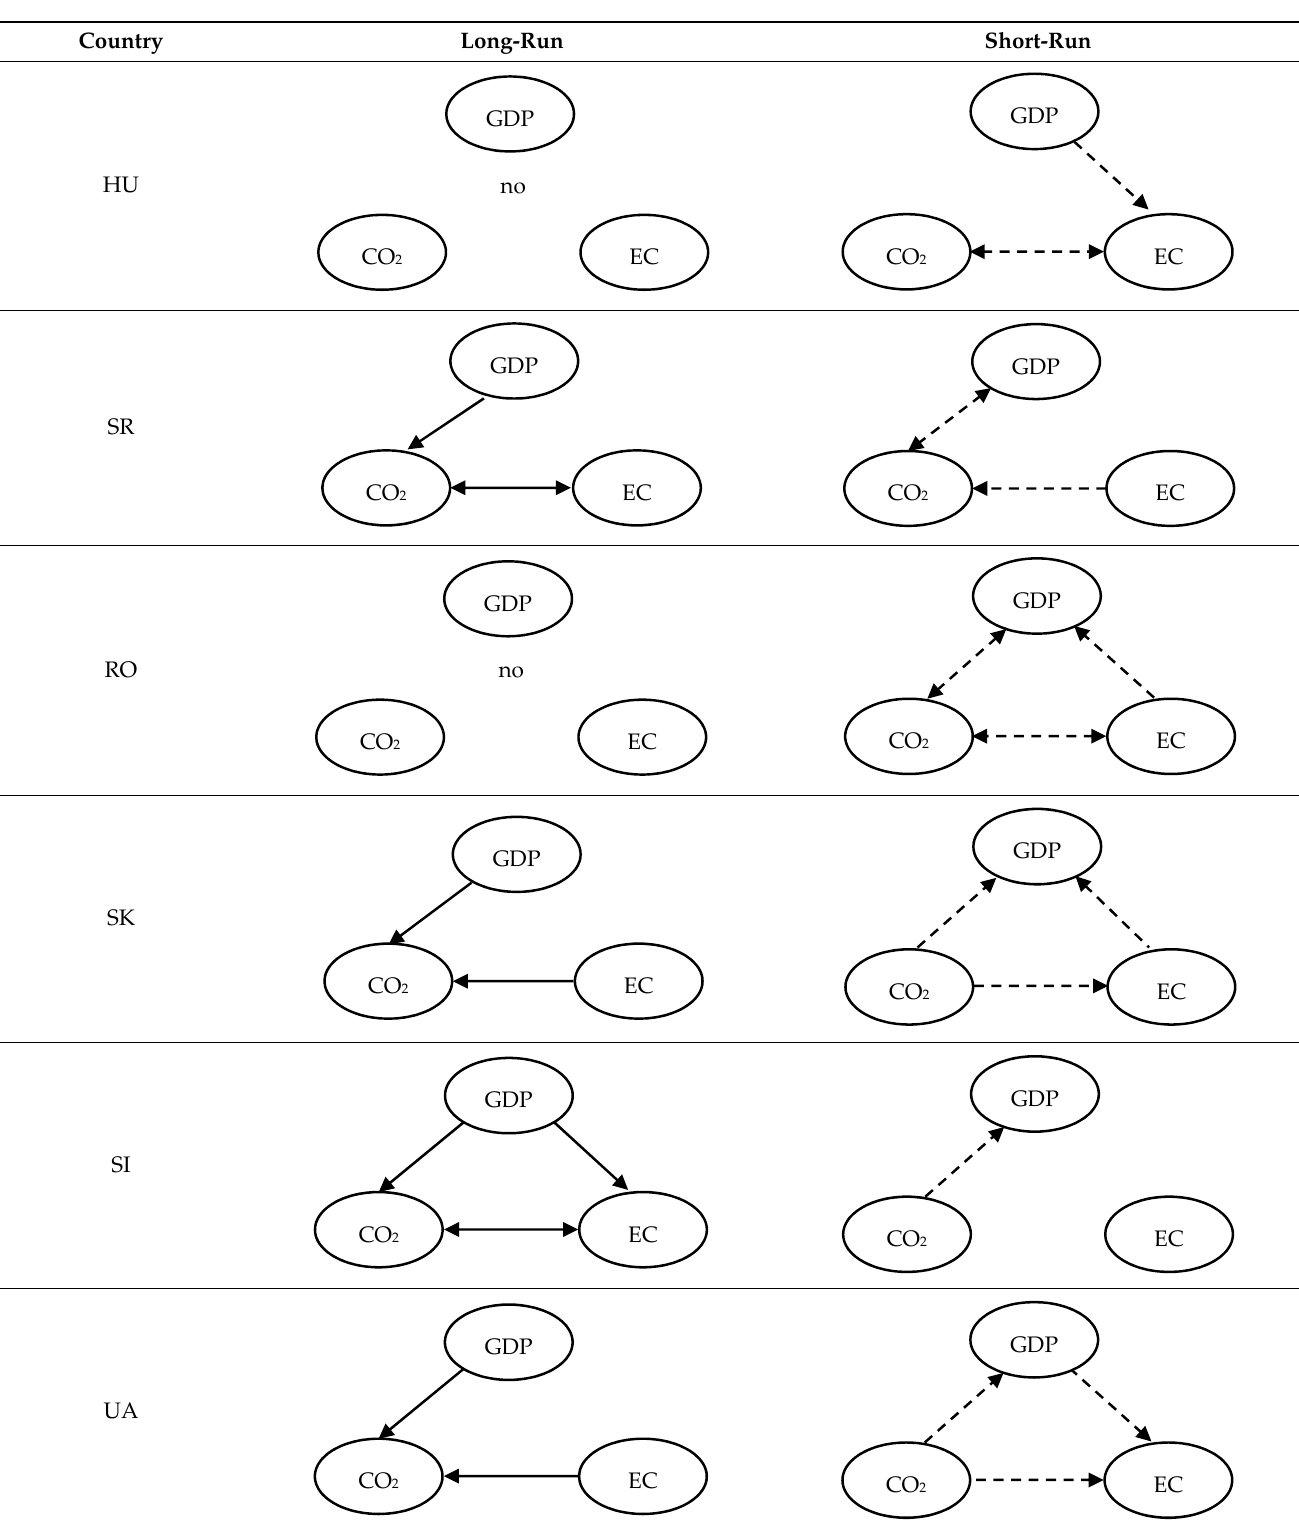
Bi-directional short-run relationship. Note 2: GDP—gross domestic product,